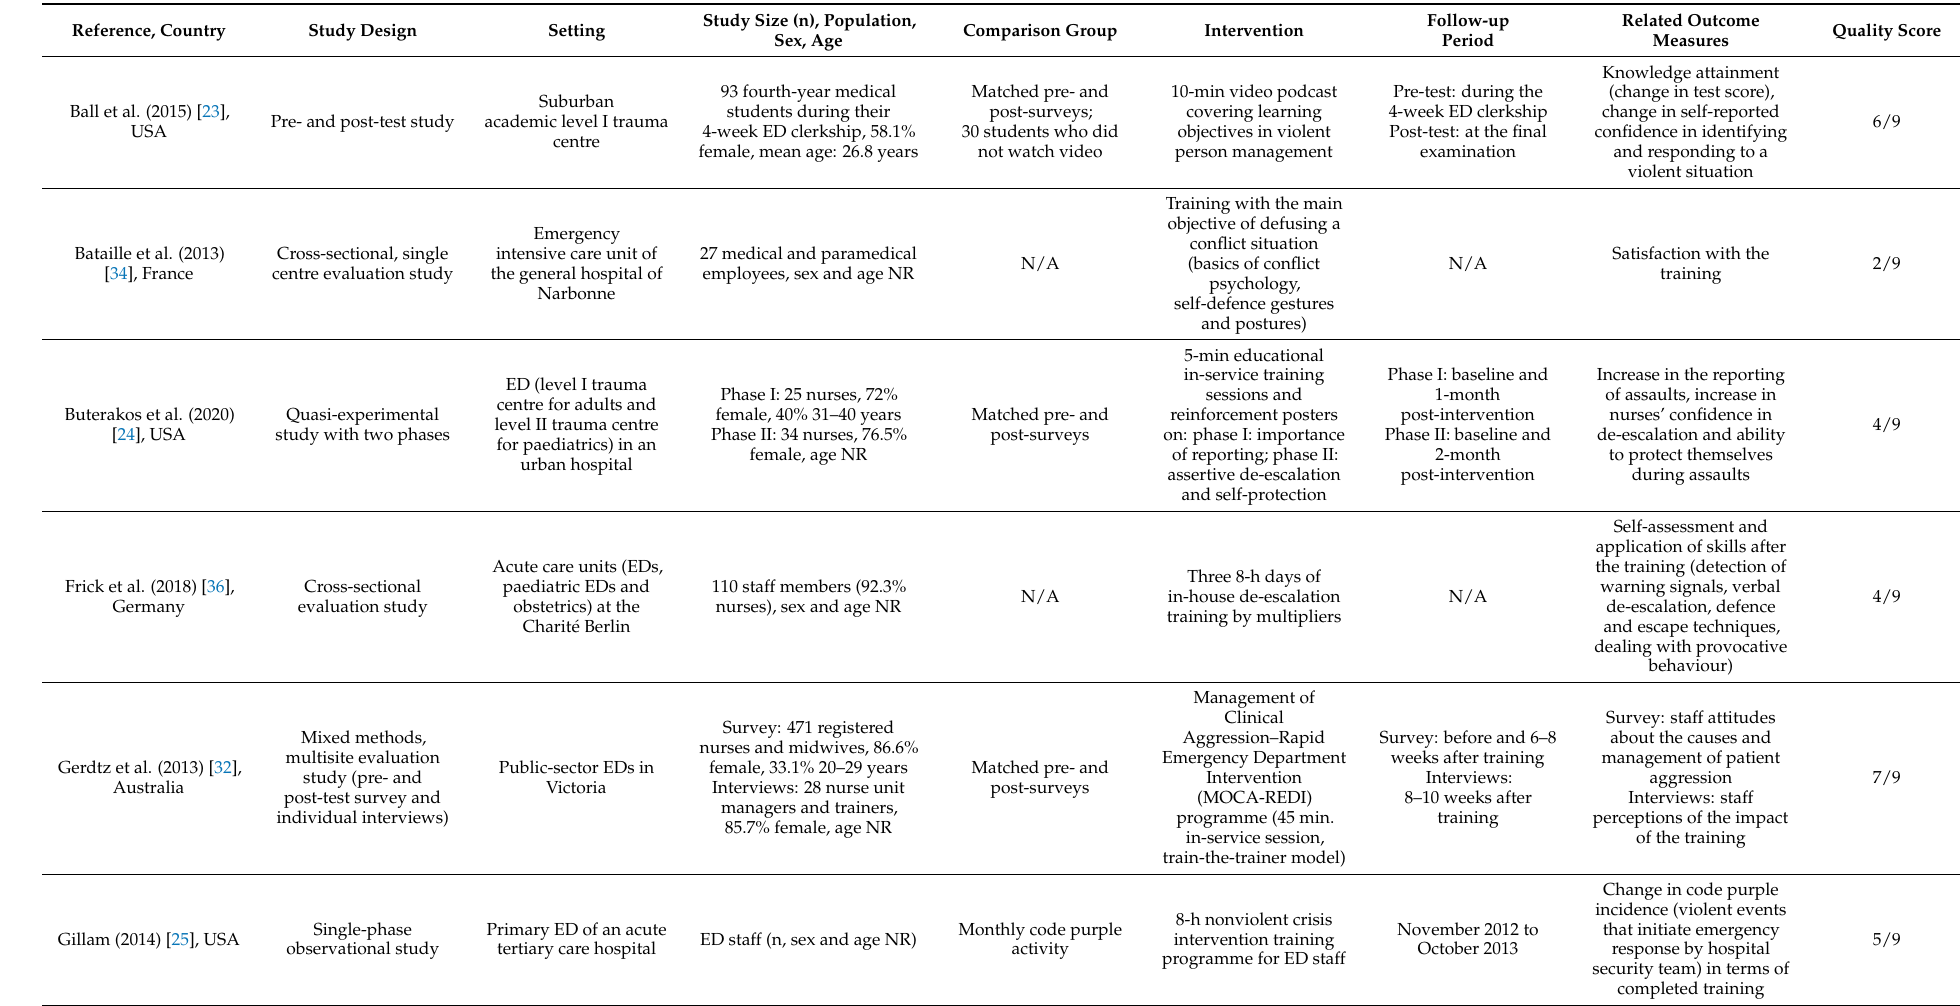
Table 2. Characteristics of the included studies (n =